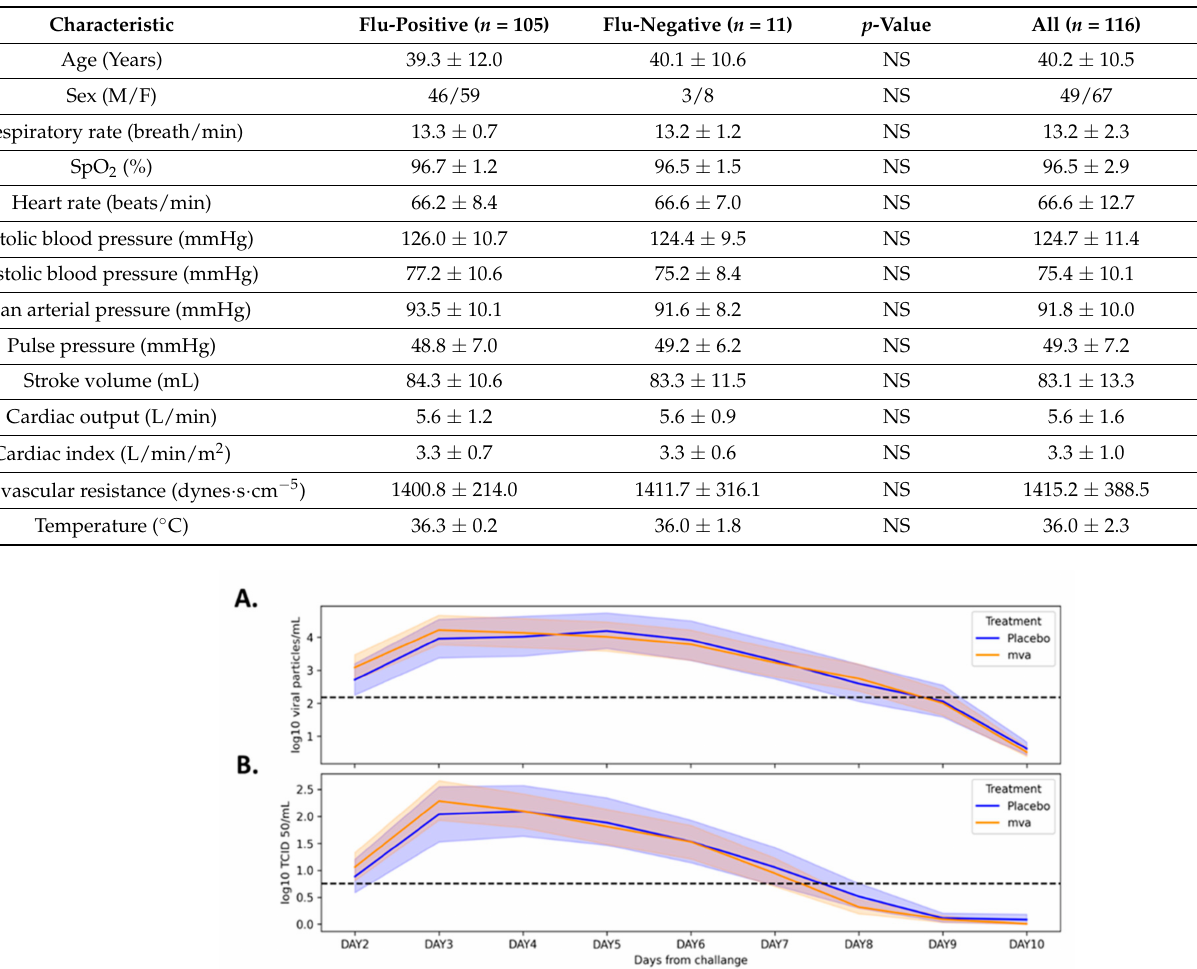
Figure 3. Changes in viral load following exposure among placebo- and MVA-treated groups. Mean ( ± 95% confidence interval) viral load as measured by real-time PCR ( A ) and titration assay ( B ) throughout the study period. MVA: modified vaccinia virus